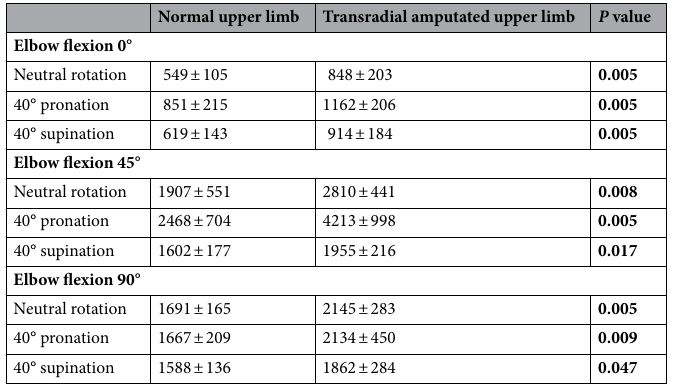
Table 5. Peak pressure of the radiocapitellar joint between normal and transradial amputated upper limbs. Boldface indicates significance. Values are presented as mean ± SD (kPa).